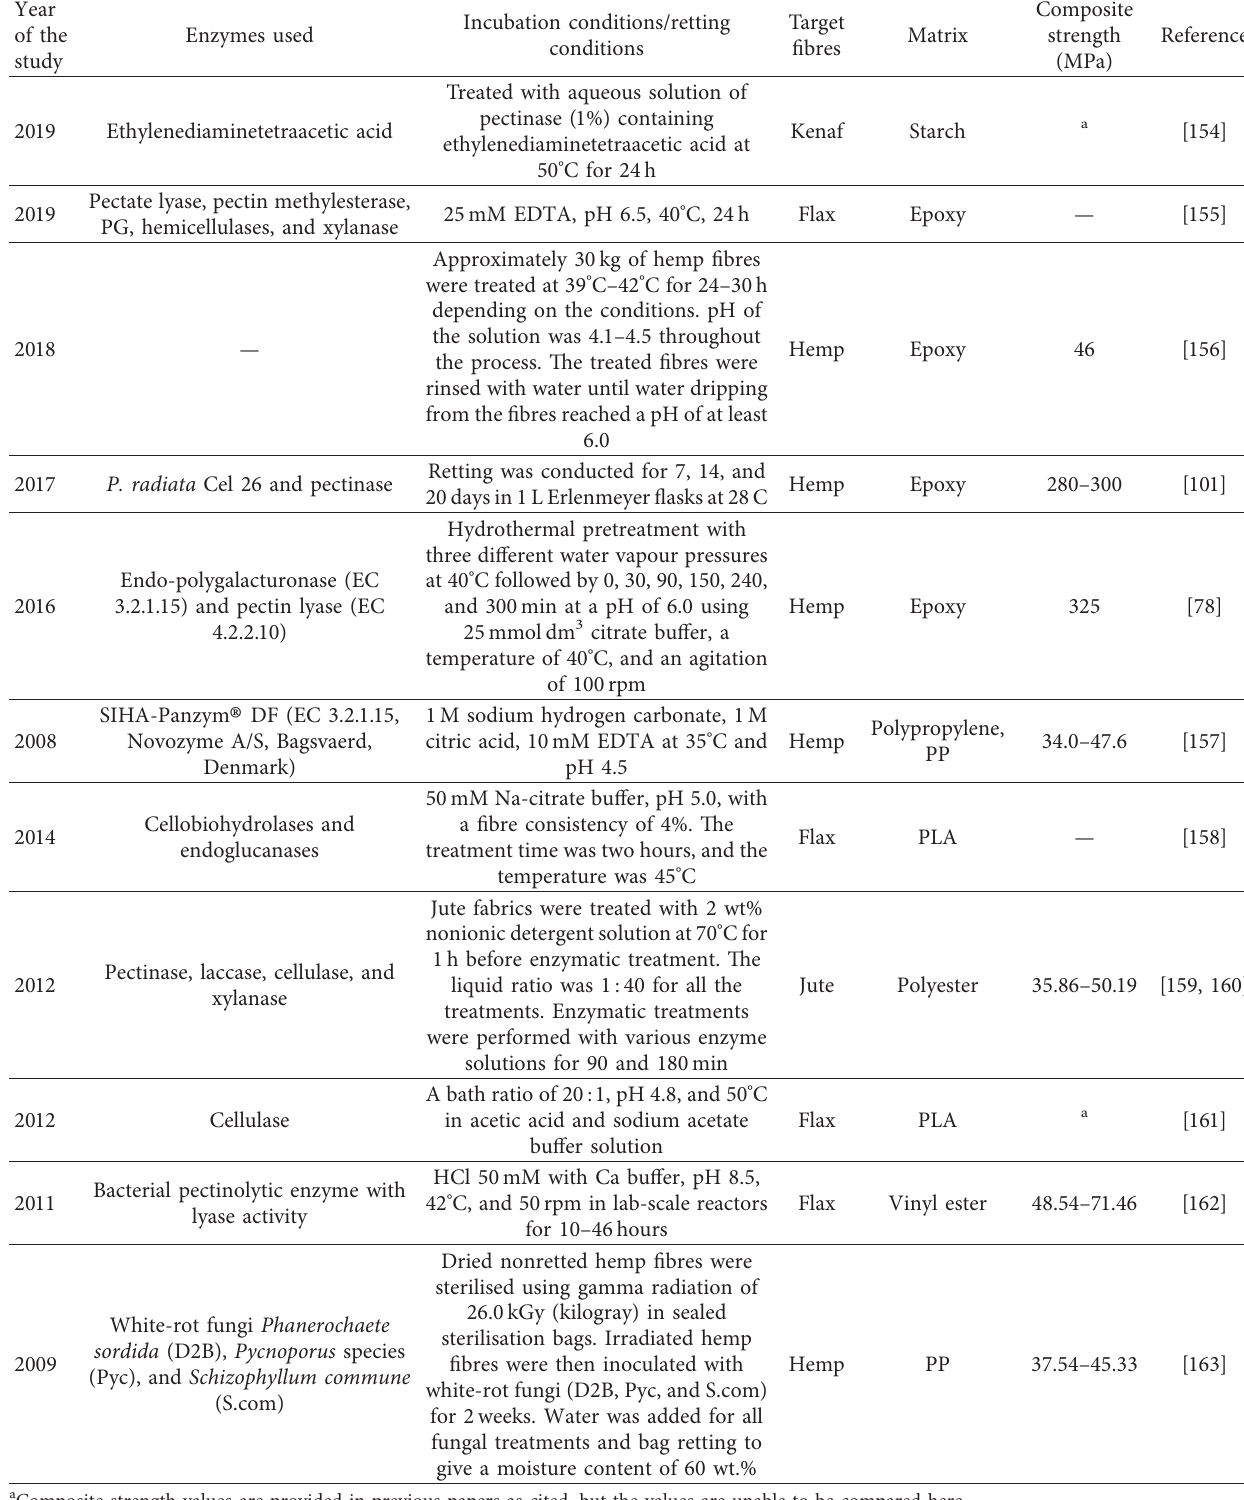
Table 6: Recent study on enzymatic-retted fibre-reinforced